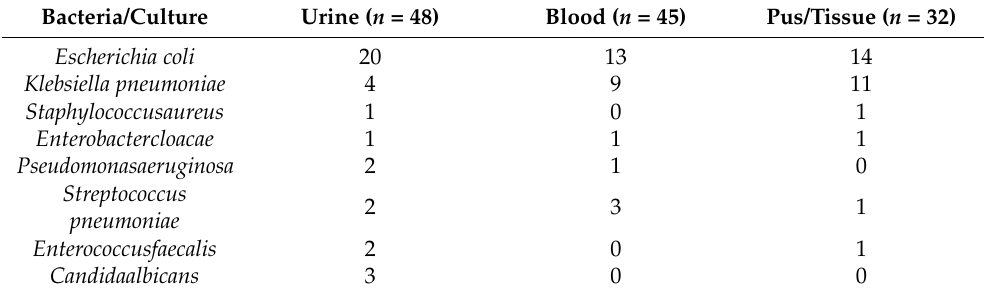
Table 4. Microbiology of EPN.